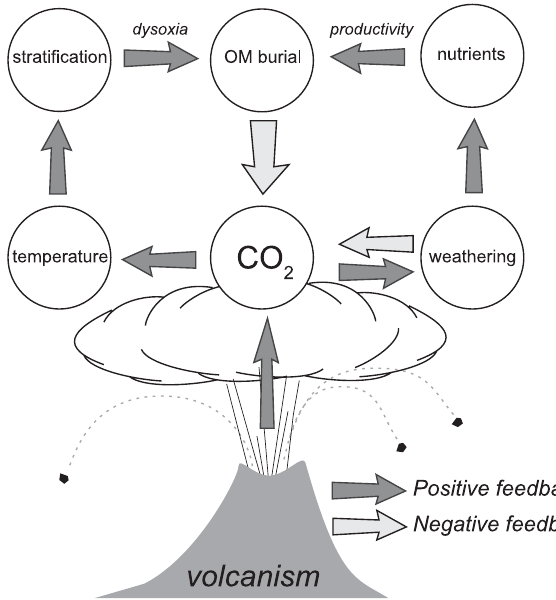
Fig. 9. Conceptual model of positive and negative feedback mecha- nisms of the Earths oceans and climate system related to changes in atmospheric p CO 2 concentrations induced by volcanism and OM